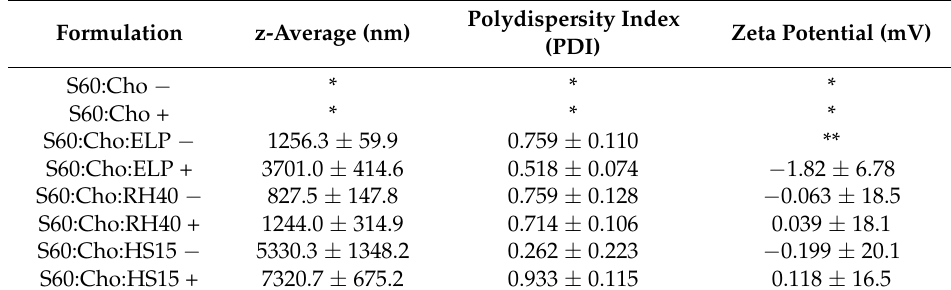
Table 3. Niosomes prepared by thin-film hydration method. * No niosomes formed or large aggregates produced; ** no data obtained. For formulation composition, refer to Table